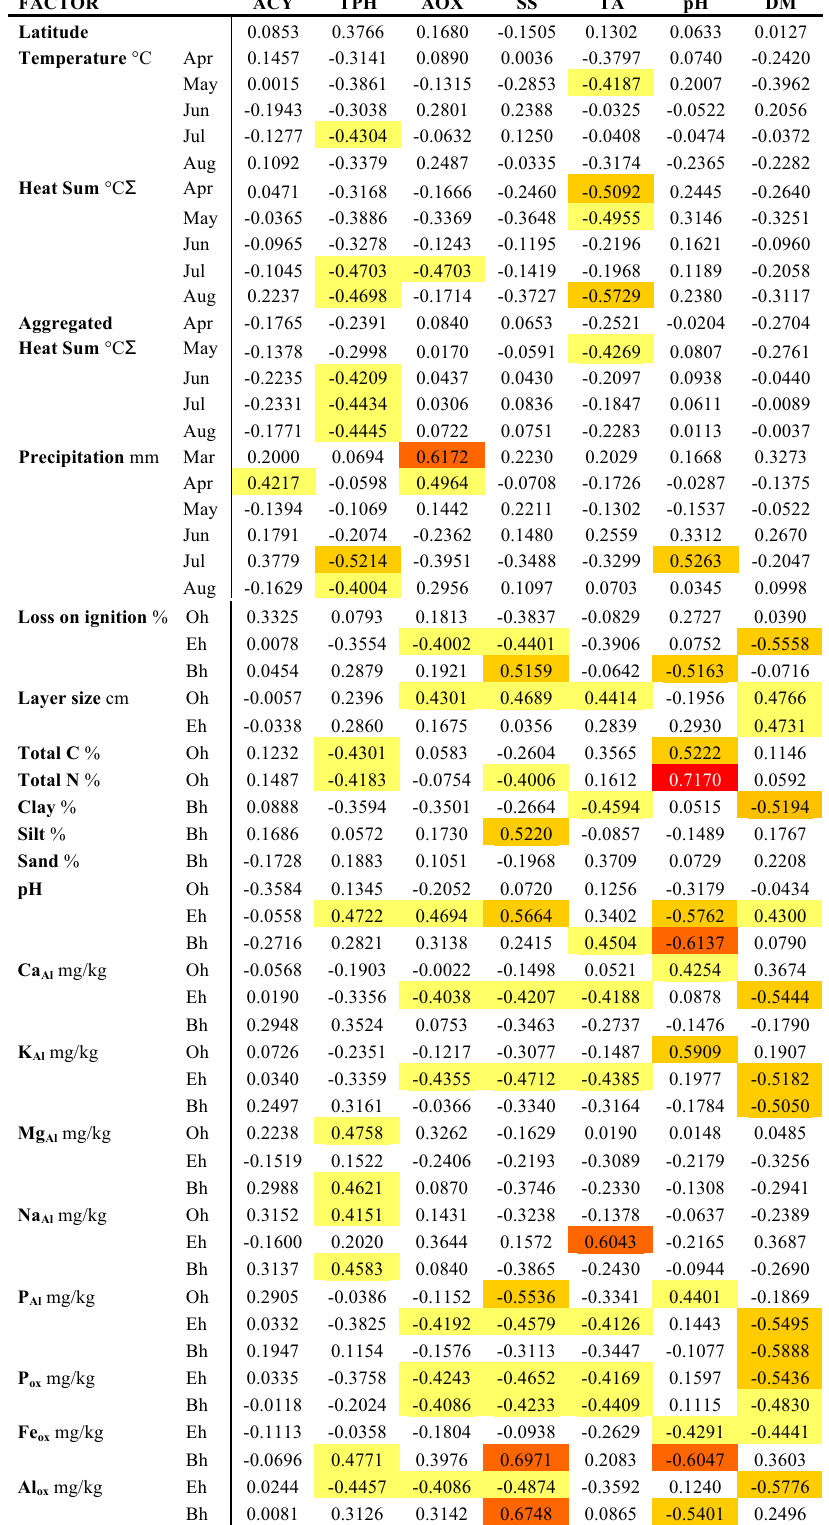
Supplementary Table S2. Pearson correlation analysis of climate (annual data) and soil factors (2009) with berry quality measurements (annual means) from corresponding field locations.